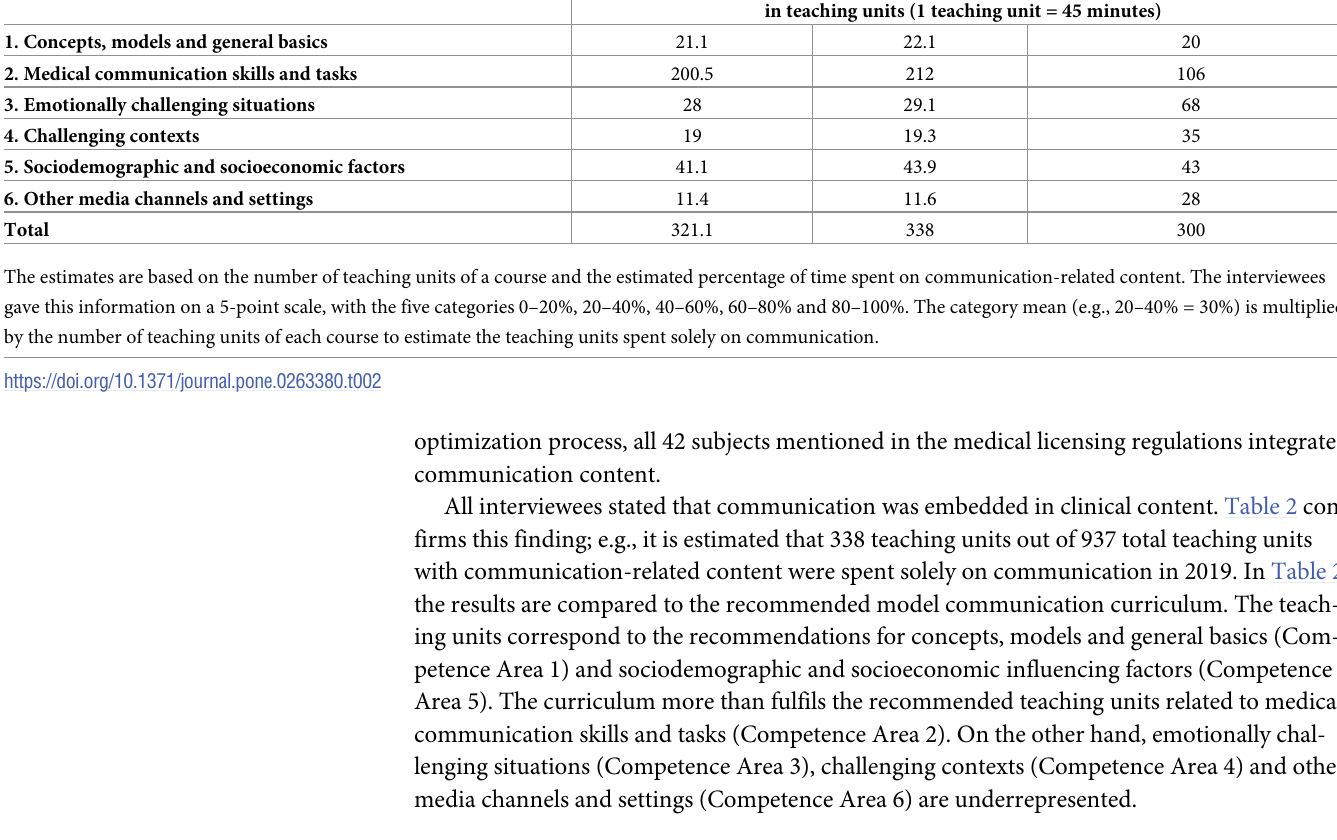
Table 2. Comparison of the estimated teaching units for the competence areas with those recommended by the model communication curriculum [19].